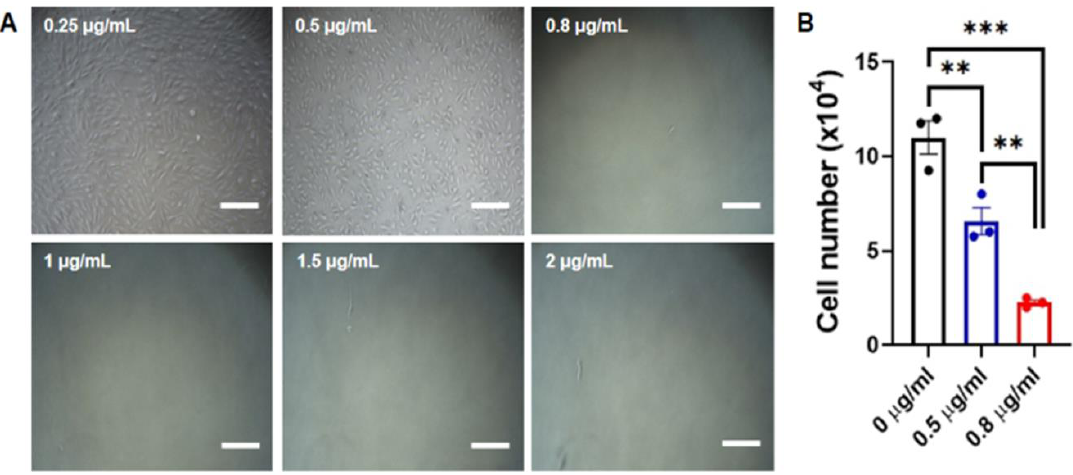
Figure 1. Determination of the optimal puromycin concentration for selecting transfected cells. ( A ) Representative images of various puromycin concentration-treated fibroblasts from a 13-year-old dog. Scale bars = 200 µ m. ( B ) The number of cells counted on 4 days after the puromycin treatment. The value represents mean ± the standard error of the mean (SEM). Data were analyzed by one-way analysis of variance (ANOVA). Asterisks indicate statistical significance (** p < 0.01, *** p < 0.005).